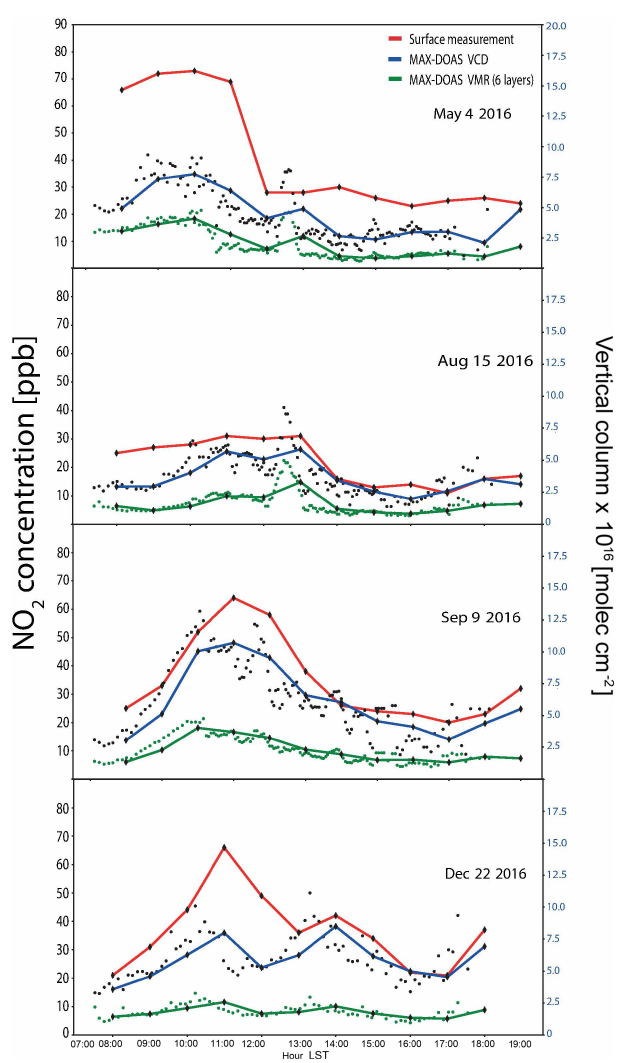
Figure 10. Example days showing the NO 2 variability in both VMR from the MAX-DOAS (green, < 550m) and surface measurements (red), as well as the total vertical column densities